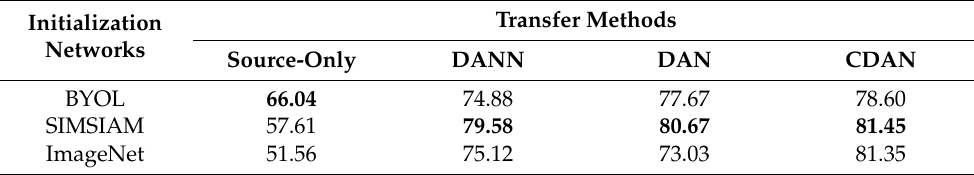
Table 4. Overall accuracy obtained by DAN, DANN and CDAN domain adaption methods based on different pretrained networks.